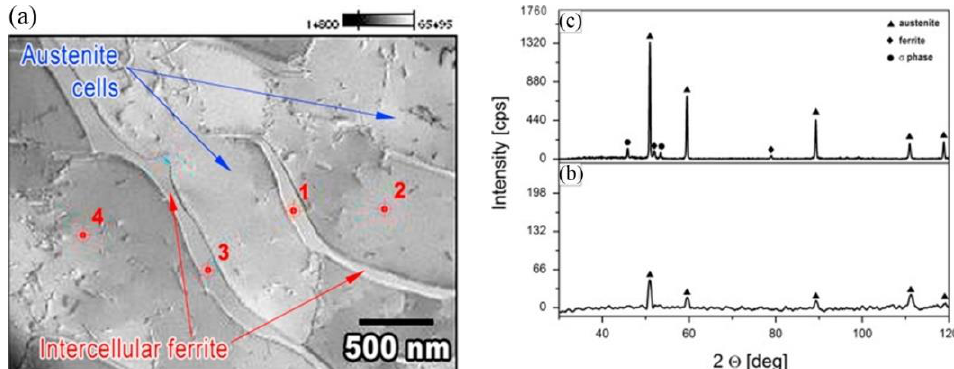
Figure 9. EBSD phase fraction map of a selected area in ( a ) the middle region of a single-built sample and in ( b ) the bottom region of a single-built sample after heat treatment. Reprinted with permission from Ref. [21]. Copyright 2015 Elsevier.